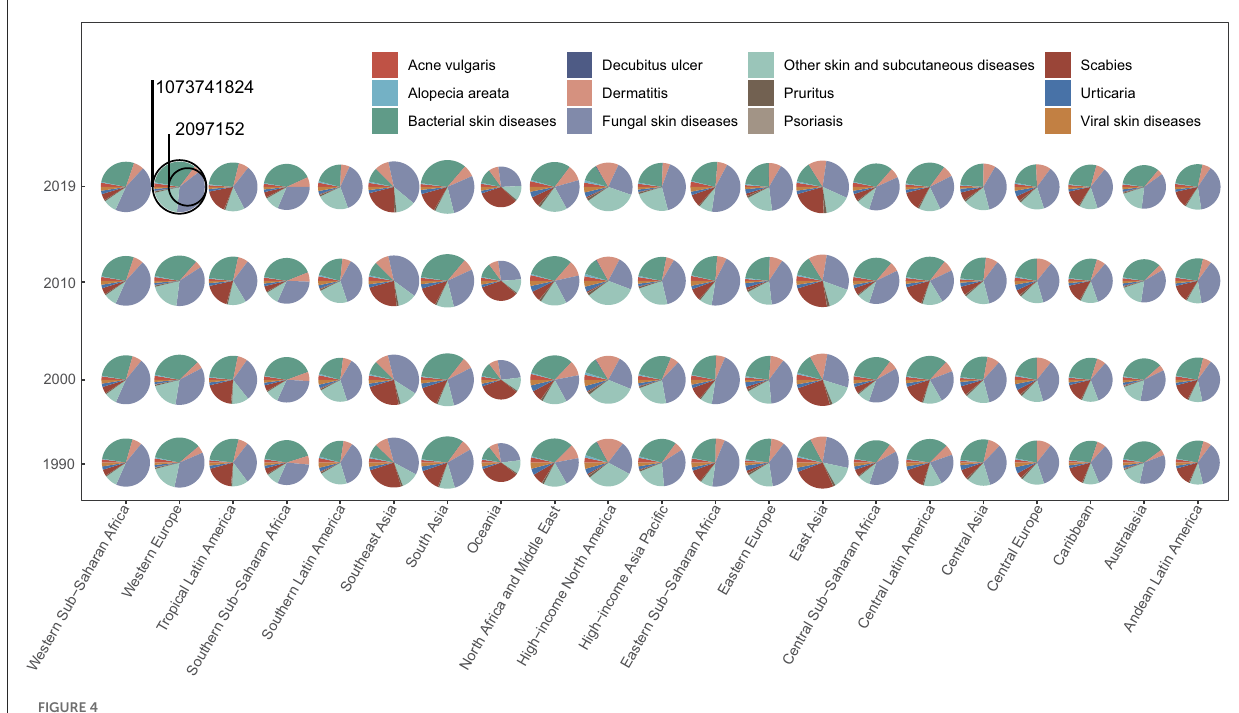
most common type of skin and subcutaneous disease in Oceania (Supplementary Figure